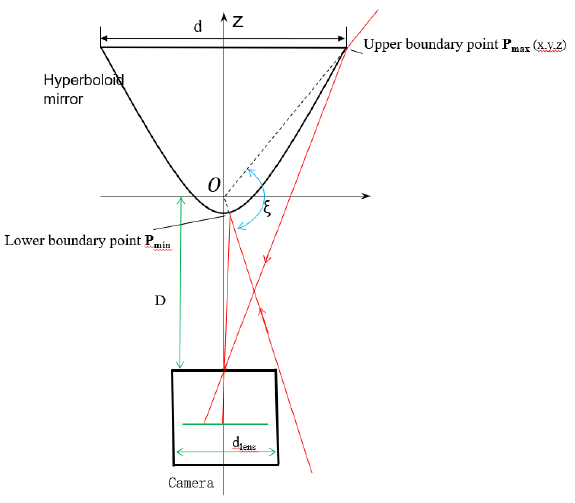
Figure 2. Schematic diagram of vertical field angle of view of hyperboloid panoramic vision sys- tems.